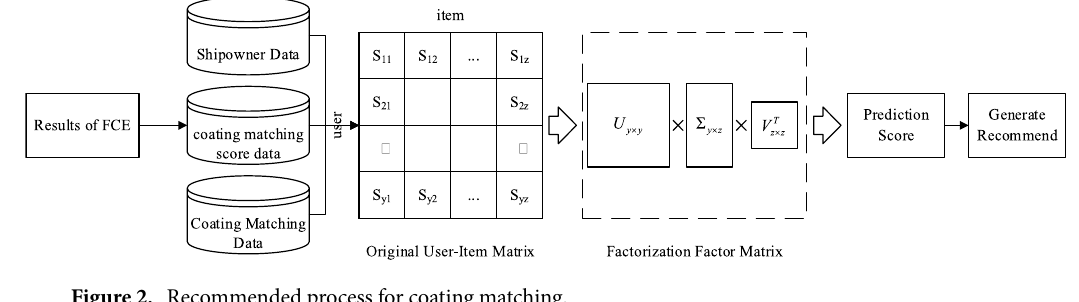
Figure 2. Recommended process for coating